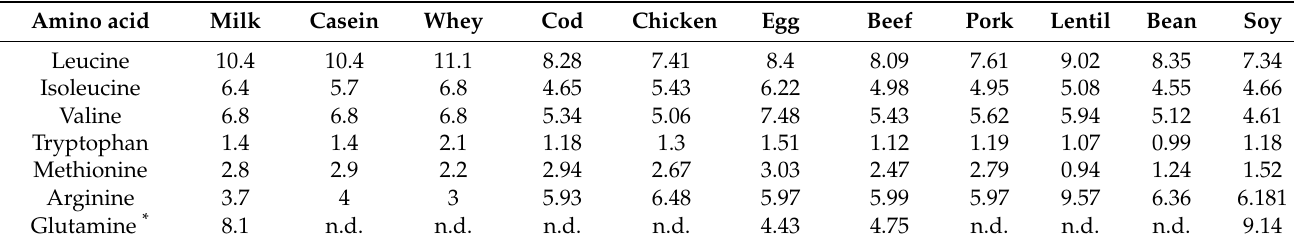
Table 1. Amino acid composition of milk proteins compared to aninmal- and plant-based protein sources (g amino acids/100 g